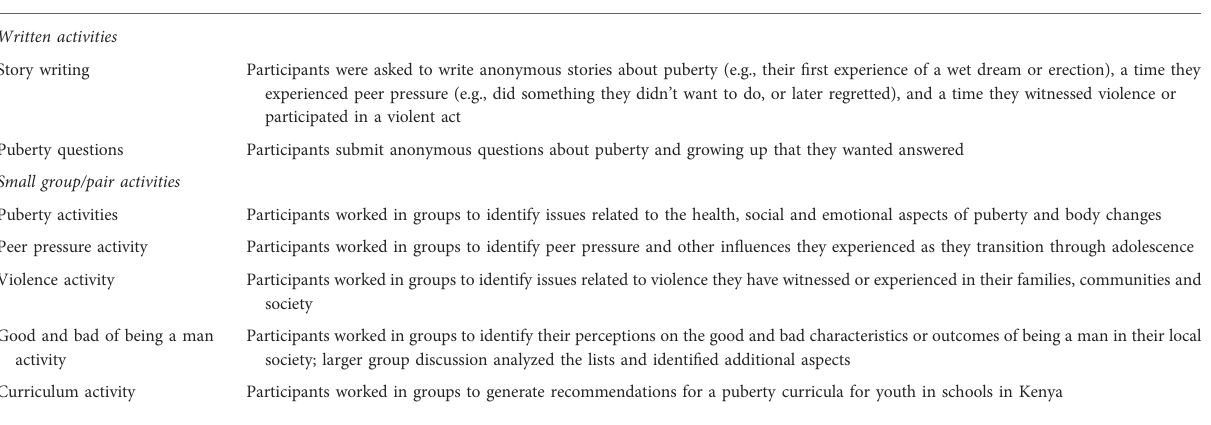
TABLE 2 Participatory methods used in the